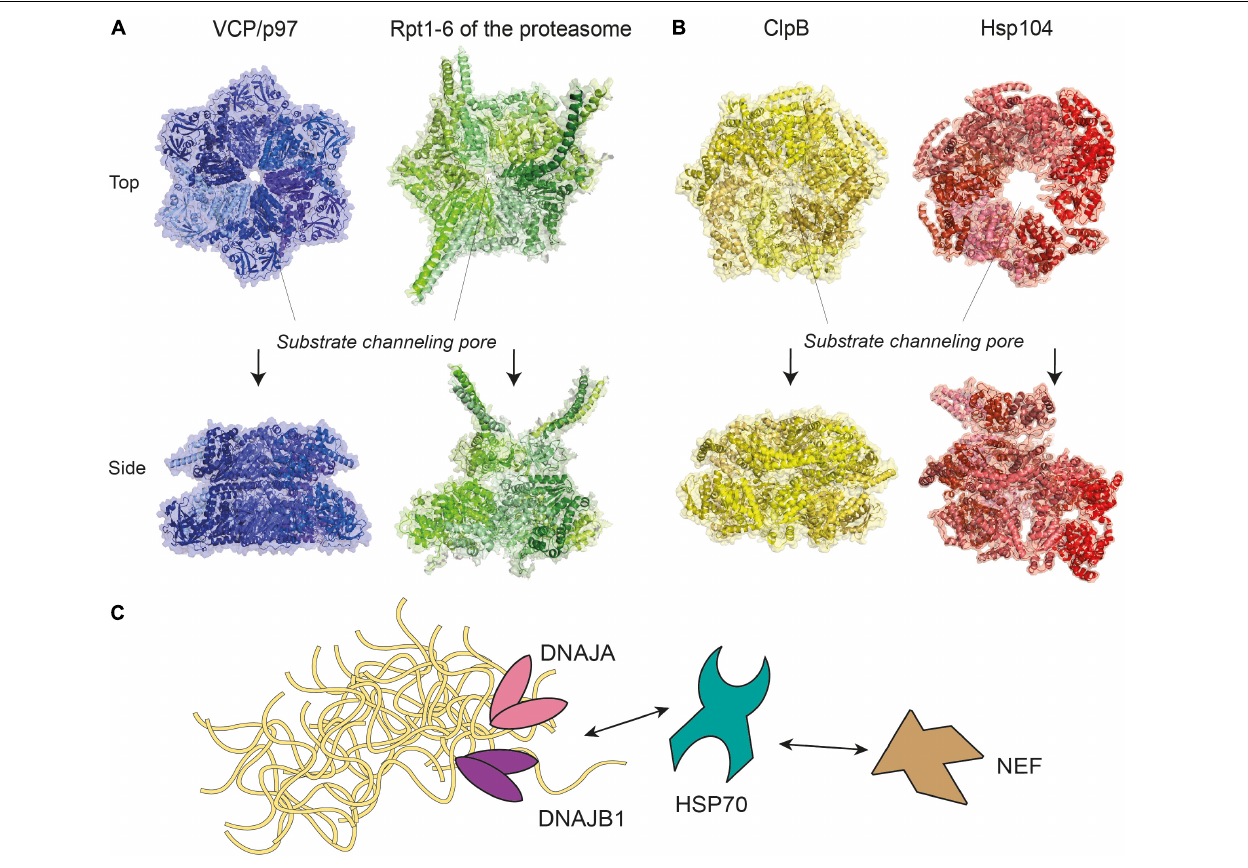
FIGURE 2 | Molecular representations of enzyme complexes with protein unfolding/refolding activity. (A) Metazoan VCP/p97 (pdb-id 5C1A) (Hanzelmann and Schindelin, 2016), a homohexamer of the same superfamily and colored in different shades of blue, shown next to the six ATPases of the 19S proteasome subparticle (see Figure 3 ), a heterohexamer consisting of Rpt1-6 (pdb-id 5GJR) (Huang et al., 2016). (B) Prokaryotic ClpB (pdb-id 6QS4) (Deville et al., 2019) and its yeast ortholog Hsp104 (pdb-id 5KNE) (Yokom et al., 2016) are homohexamers of the AAA+ ATPase superfamily. For clarity, identical subunits within the same complex are colored with different shades of the same color scheme. The positions of substrate channeling pores are indicated with dotted lines. (C) A model of the HSP70 disaggregase machinery, where HSP70 work together with DNAJA, DNAJB1, and nucleotide exchange factor (NEF) to target aggregates of various sizes. Double-headed arrows represent reversible interactions between